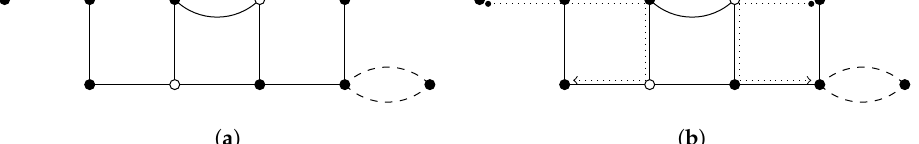
(cid:108) (cid:108) T , where sig ( T i ) Fr = dL . White vertices are right wall vertices i + 1